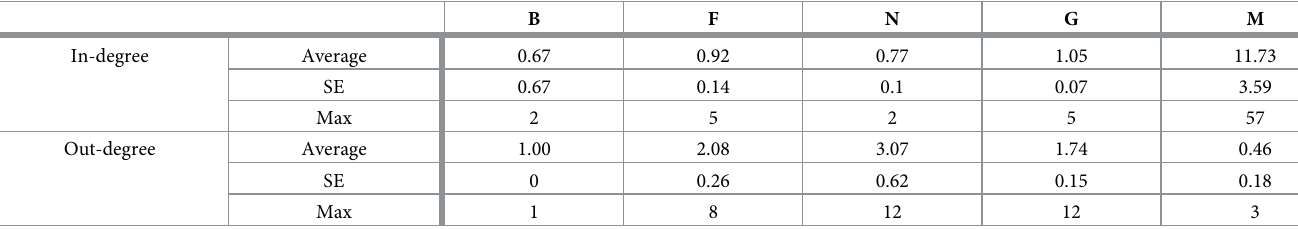
Table 2. Movement network degree centrality data